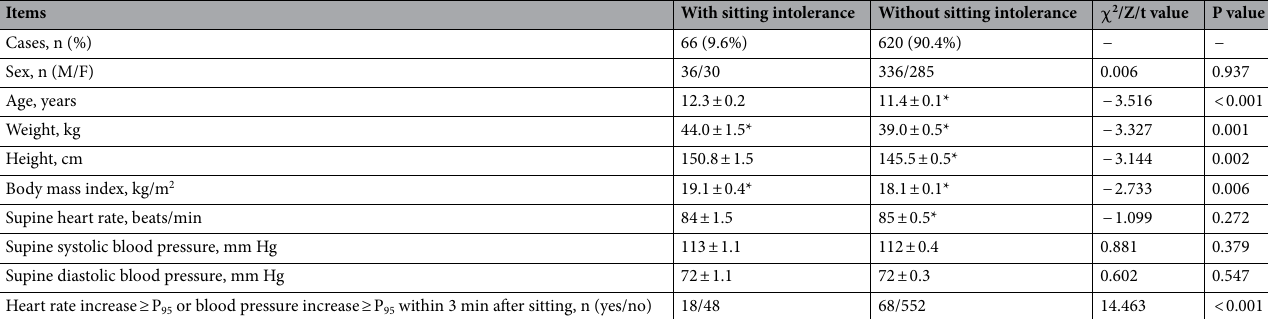
Table 2. Comparison of baseline characteristics for participants with and without sitting intolerance. Data are mean ± SE. M male, F female. *Continuous variables with non-normal distribution.